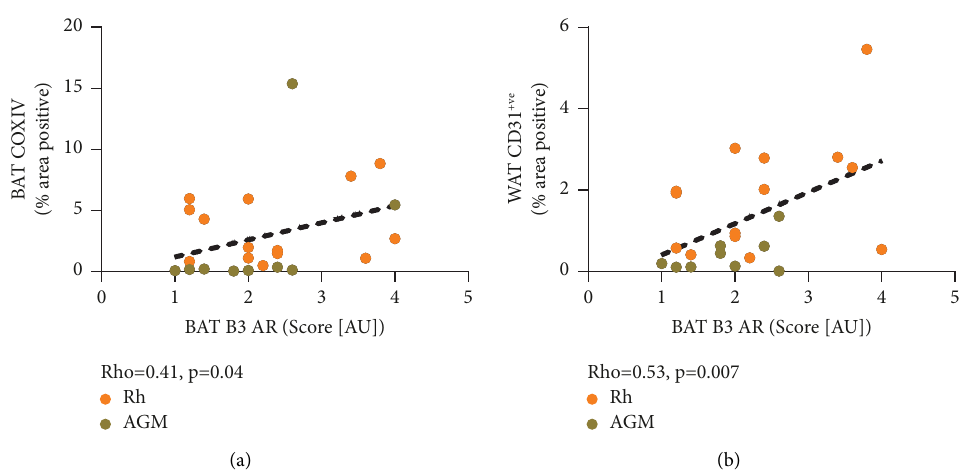
Figure 3: Signifcant correlations with the beta 3 adrenergic receptor. Panel (a) depicts the positive relationship between abundance of beta- 3 adrenergic receptor ( β 3-AR) and cytochrome c oxidase subunit 4 (COX IV) ( p value � 0.04, Rho � 0.41, n � 25) in brown adipose tissue. Panel (b) depicts the positive relationship between brown adipose tissue beta-3 adrenergic receptor ( β 3-AR) abundance and white adipose tissue cluster diferentiation 31 (CD31) ( p value � 0.007, Rho � 0.53, n �